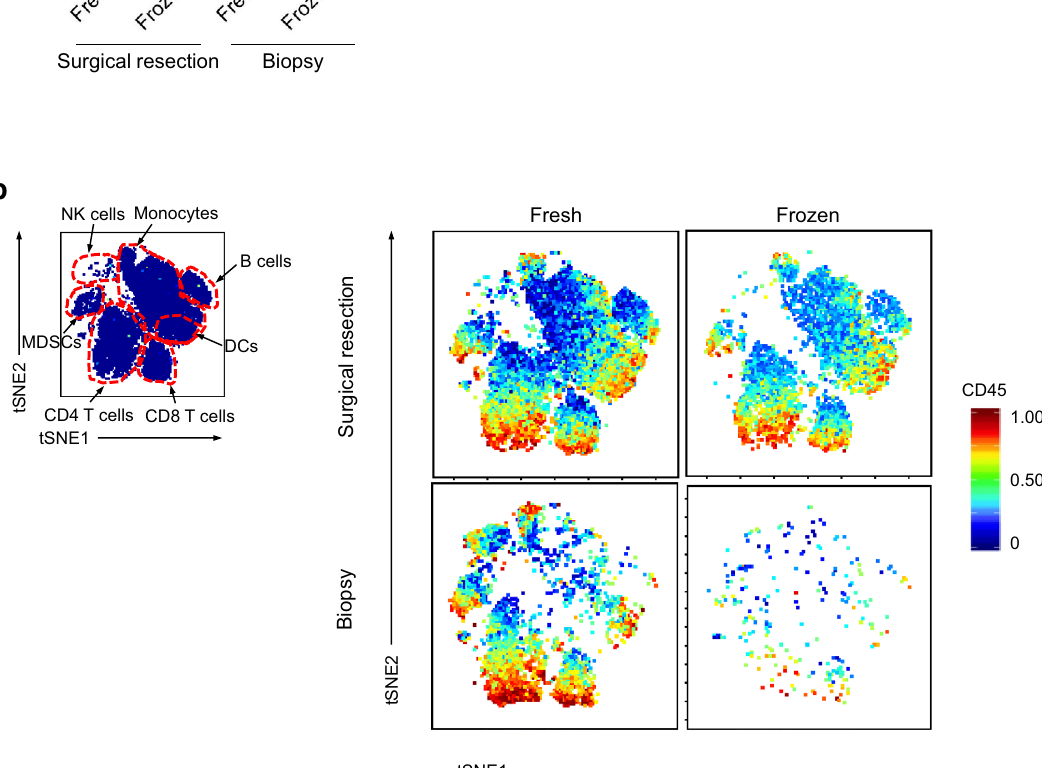
Figure 1. Freshly isolated cells showed better viability and detection compared with frozen samples in CyTOF. ( a ) The number of CD45 cells identified from the fresh and frozen surgically- and biopsy-resected samples. ( b ) Their representative staining figures. Fractions with approximately 5 mm square size from surgically resected samples or three fractions from biopsy samples were used for CyTOF. After sampling, the tumor tissues were minced by gentleMACS. Half of the cell suspension was applied for CyTOF at the fresh state, and the remaining one was stocked, which was analyzed a few weeks later. *p <